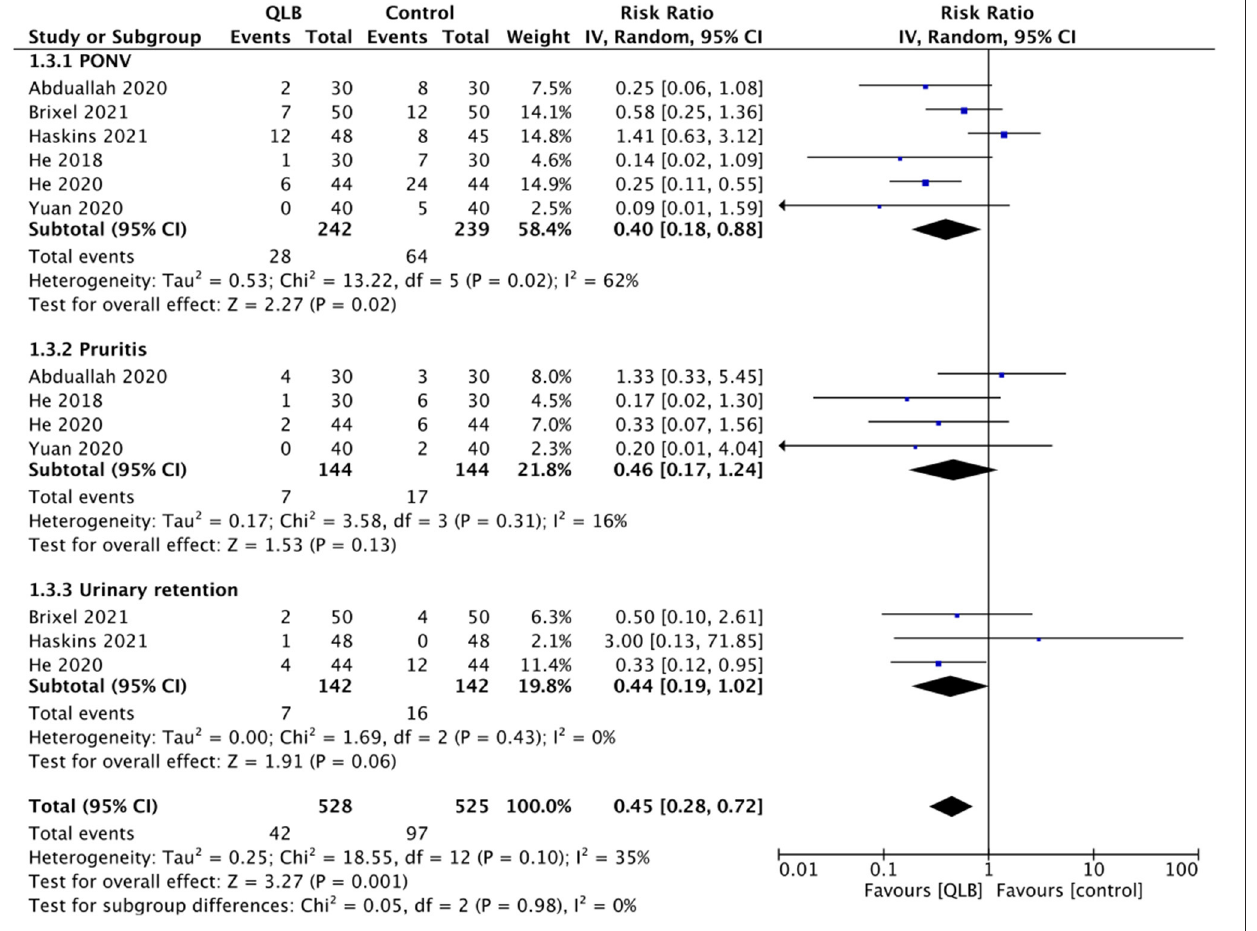
FIGURE 6 | Meta-analysis of adverse events between QLB and control